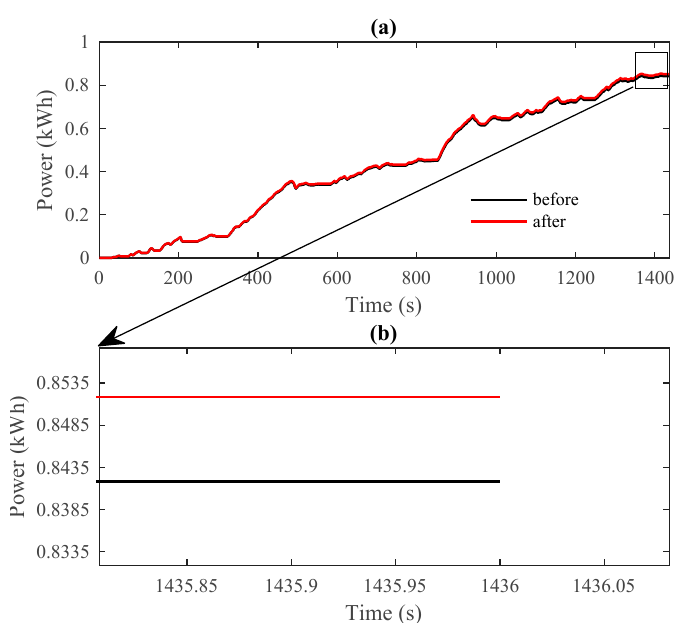
Figure 10. Power consumption with and without shift stability control.